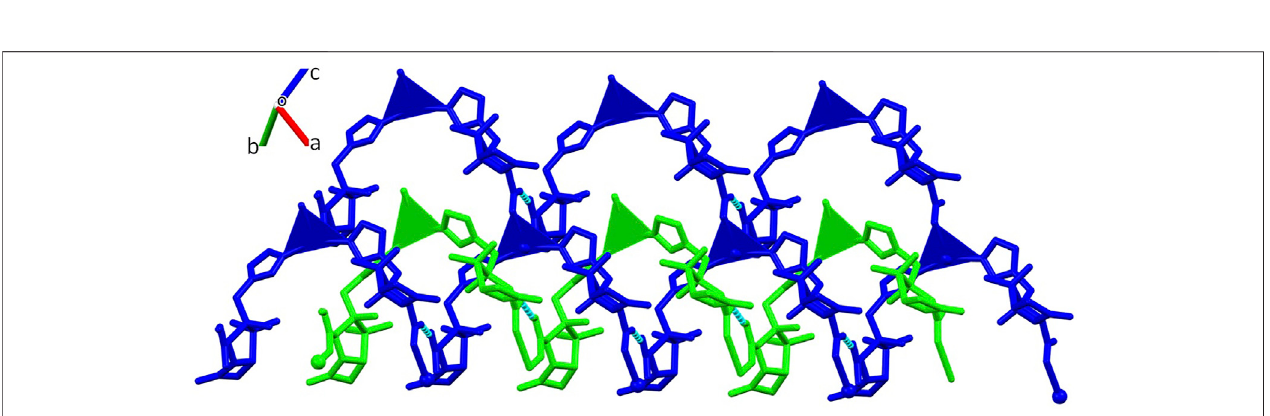
FIGURE5| Schematicrepresentationof (A) thecoordinationsitesand (B) thecoordinationgeometryaroundtheAg(I)sites(hydrogenatomshavebeenomittedfor clarity reasons) for [Ag(I)-Tazo 2 ].